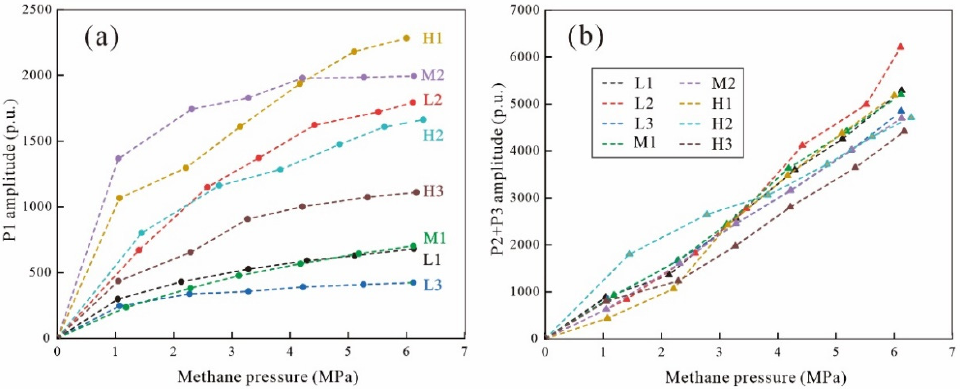
Figure 6. NMR P1 ( a ) and P2 + P3 ( b ) amplitude changes during the process of methane